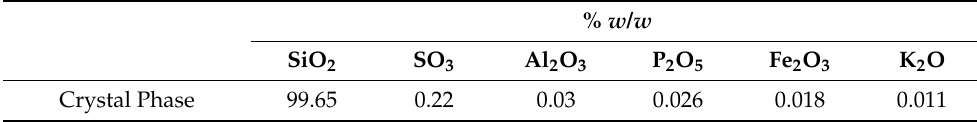
Table 1. Semiquantitative analysis of the crystal phase of the sludge.